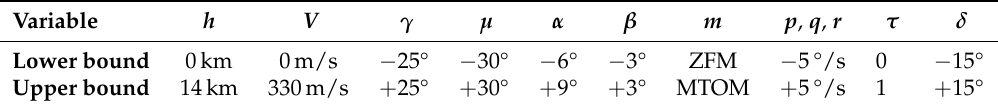
Table 1. Default bound constraints imposed on state and control